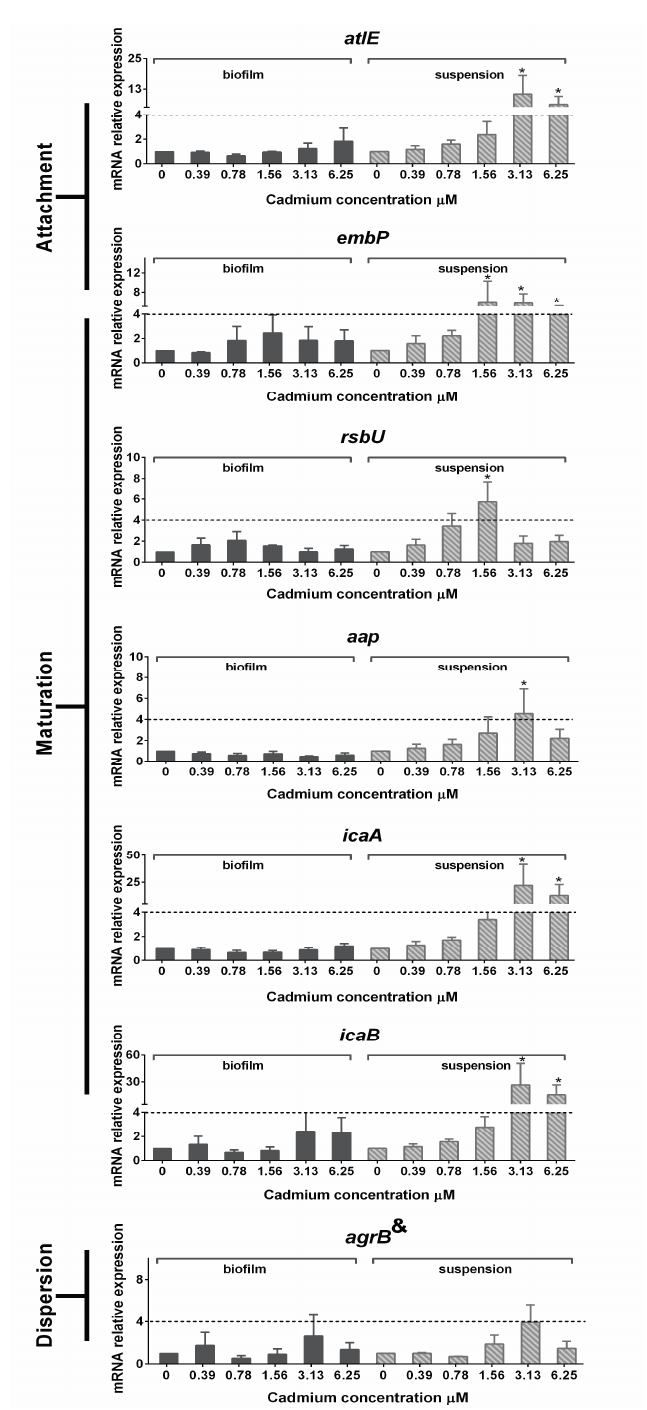
Figure 6. Mean (±SEM) relative expression of mRNA encoding genes involved in biofilm formation and quorum sensing. * indicate significant relative down- or up-regulation of genes when compared with untreated controls. & indicate agrB is considered to be involved in bacterial attachment and biofilm